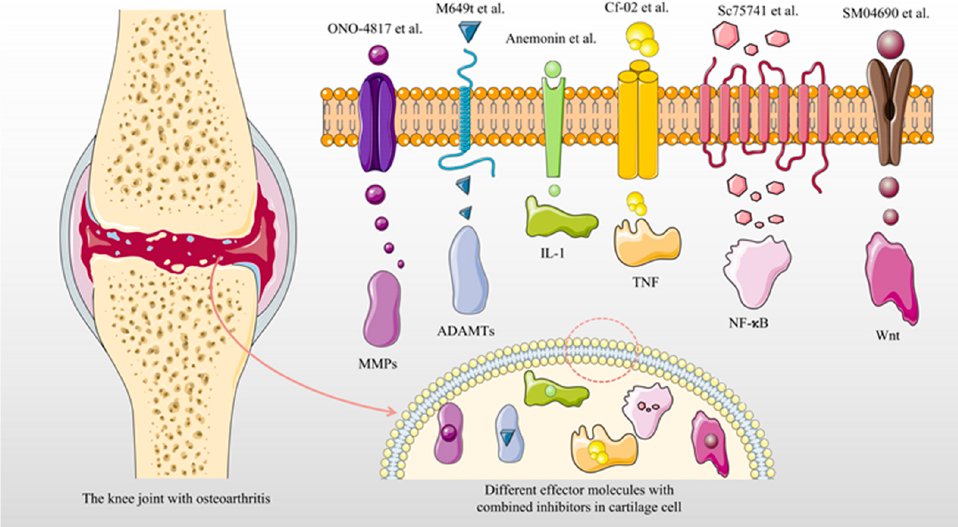
Figure 1. Small molecule inhibitors in osteoarthritis combined with their targeted proteins or genes